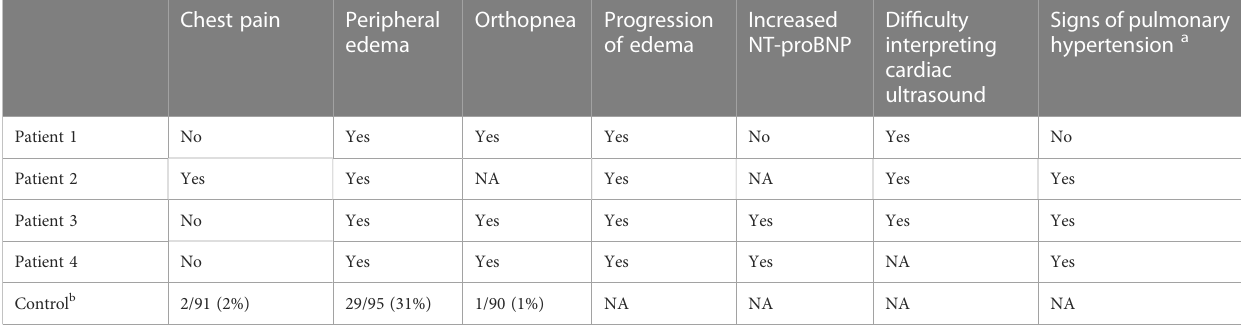
TABLE 2 Physical complaints and signs of cardiac decompensation of four patients with PWS with cardiovascular events, compared to 117 PWS adults without cardiovascular